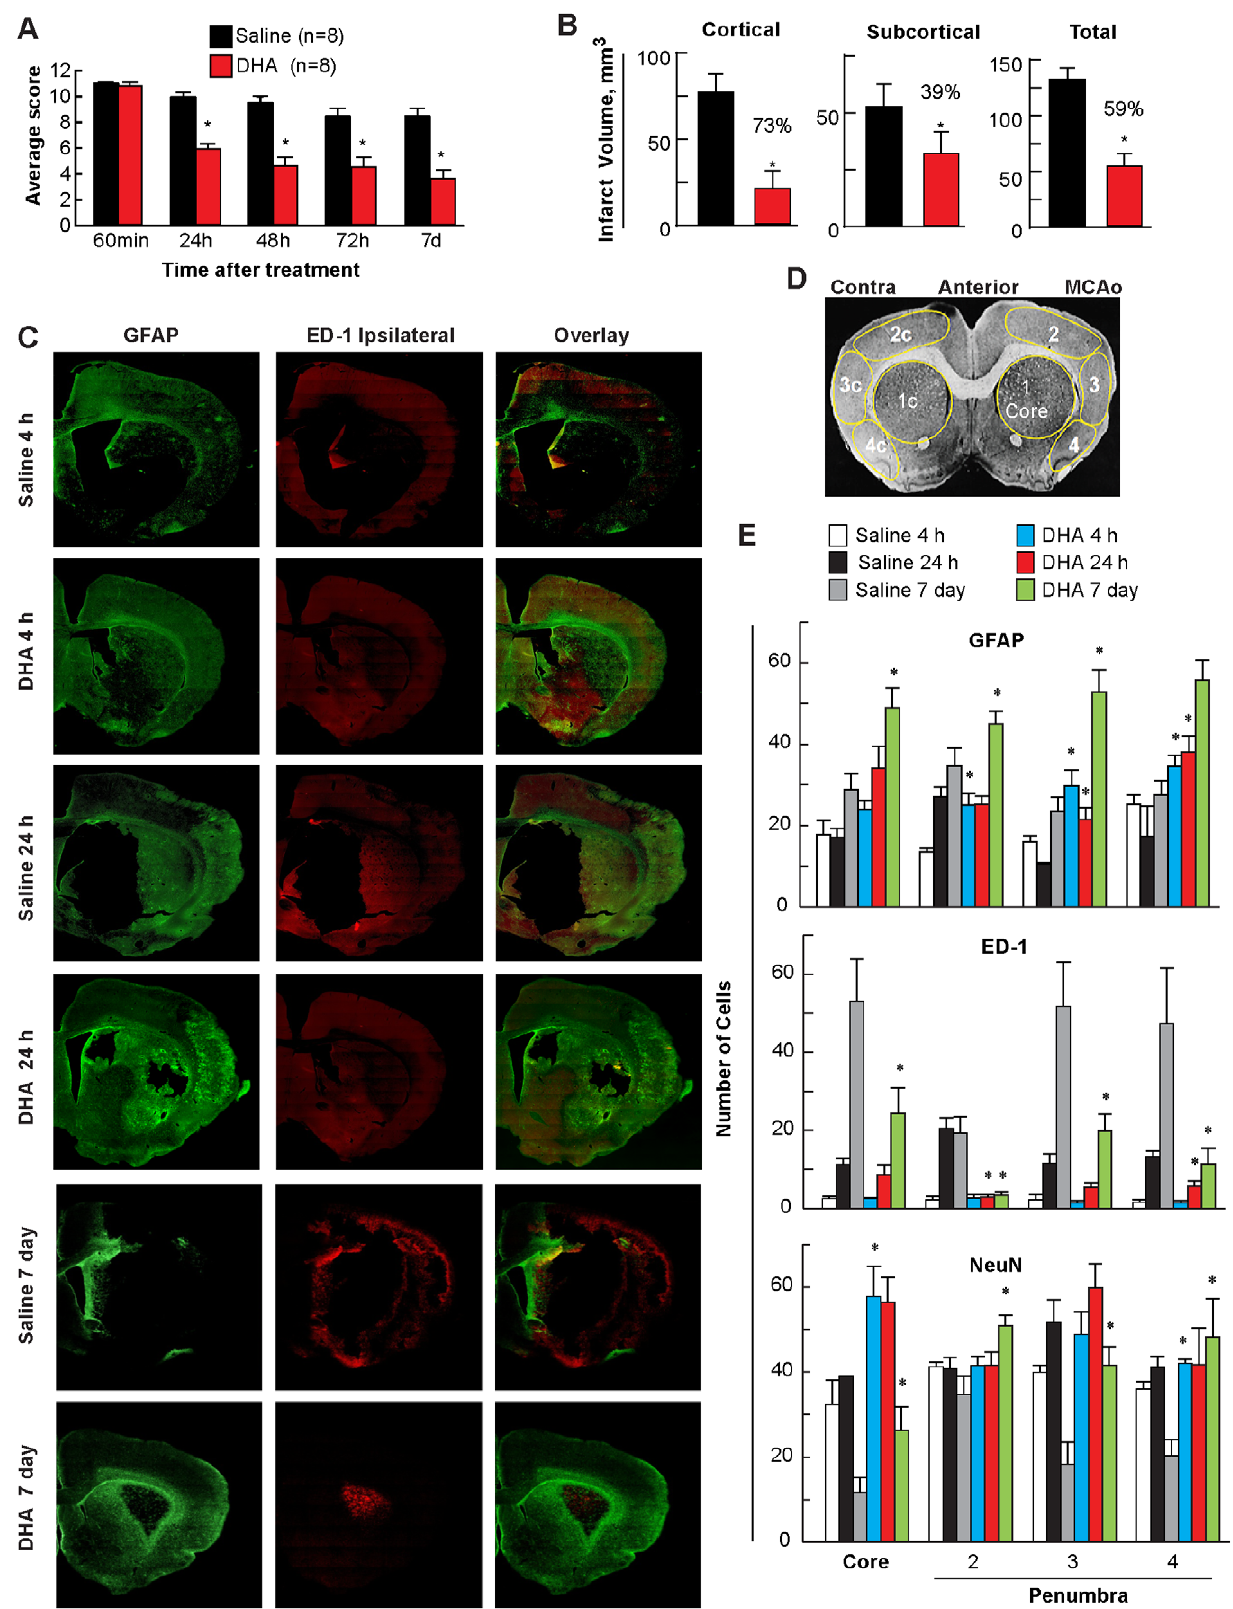
Figure 1. Behavioral, histopathology and immunohistochemistry in young rats. Panel A: Total neurological score at 24, 48, 72 h, and 7 days after MCAo. Panel B: Cortical, subcortical and total infarct volumes on day 7 after stroke. Panel C: Computer-generated MosaiX-processed images